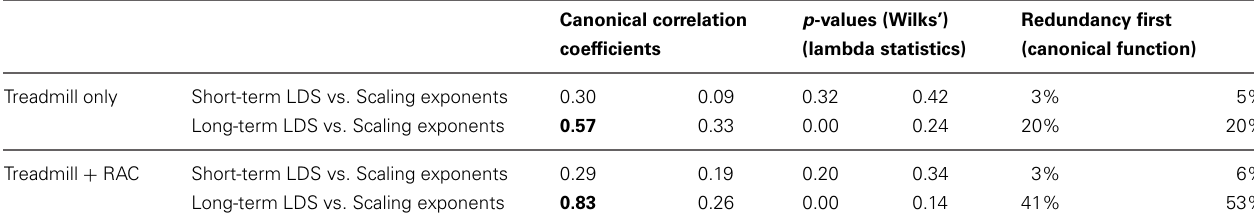
Table 1 | Canonical correlation analysis